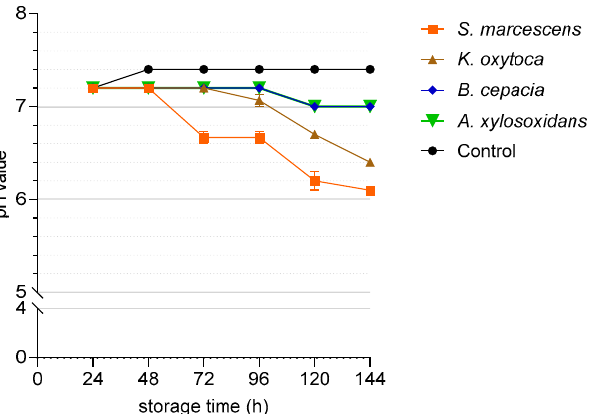
Figure 5. pH values in extended semen spiked with four different multidrug-resistant bacterial species at ~10 3 CFU/mL. The samples extended in Beltsville Thawing Solution were stored at 17 °C for 144 h. Data are means and SEM (n = 3).